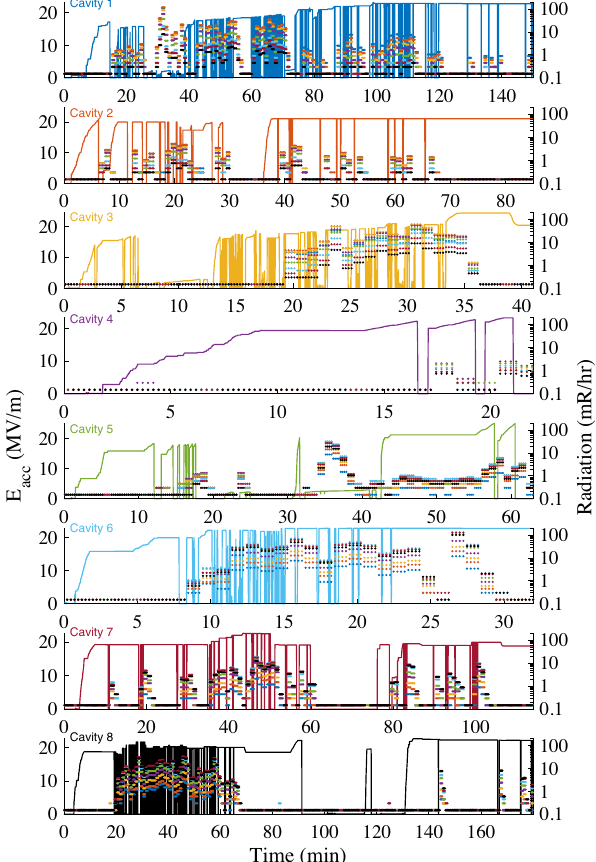
FIG. 9. Quench processing of the eight vCM cavities after the initial ramp to 16 MV = m. The solid lines are cavity gradients and the dots are readings from the radiation detectors located along the side of the module, which have an integration time of ∼ 1 minute. Detector colors correspond to those in Fig. 5. Some cavities have pauses in testing removed from the plots for ease of